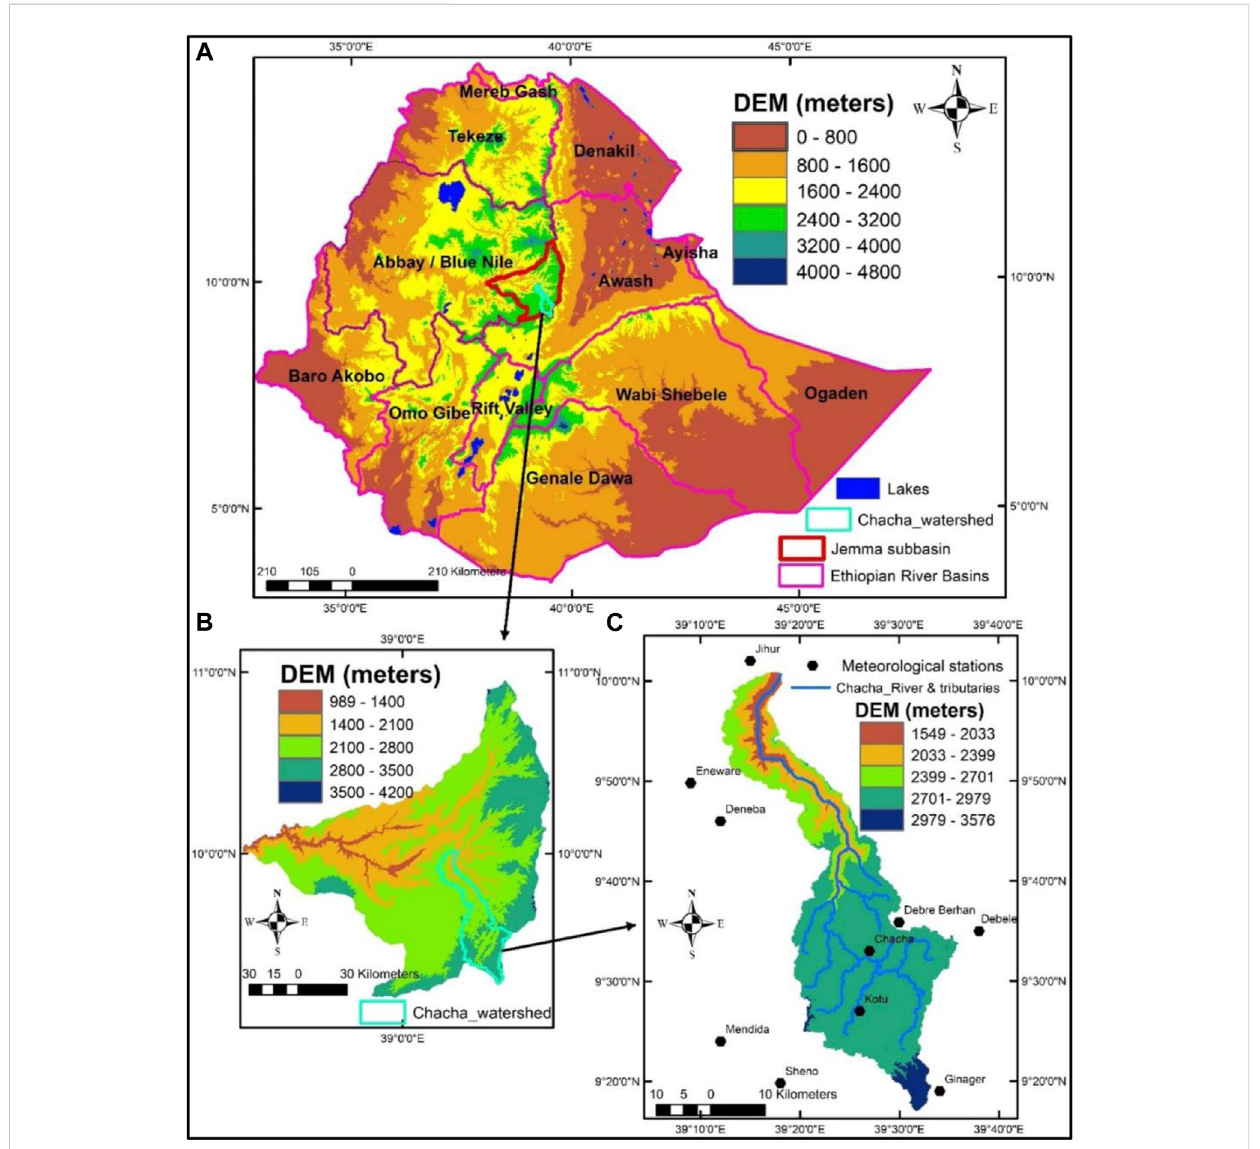
FIGURE 1 Map of the study area: (A) River Basins of Ethiopia; (B) Jemma River Sub-basin; and (C) Exact study area (i.e., the Chacha River Watershed).